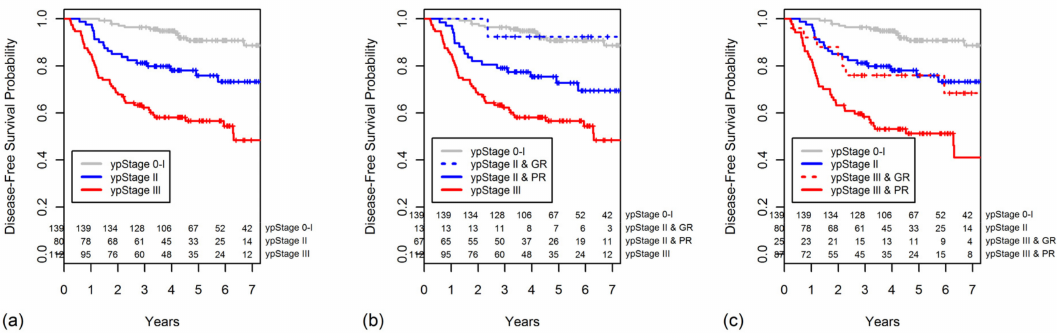
Figure 2. Disease-free survival curves are shown for categories of ( a ) ypStage, ( b ) ypStage II group was dichotomized as good response (GR) or poor response (PR), and ( c ) ypStage III group was dichotomized as GR or PR.